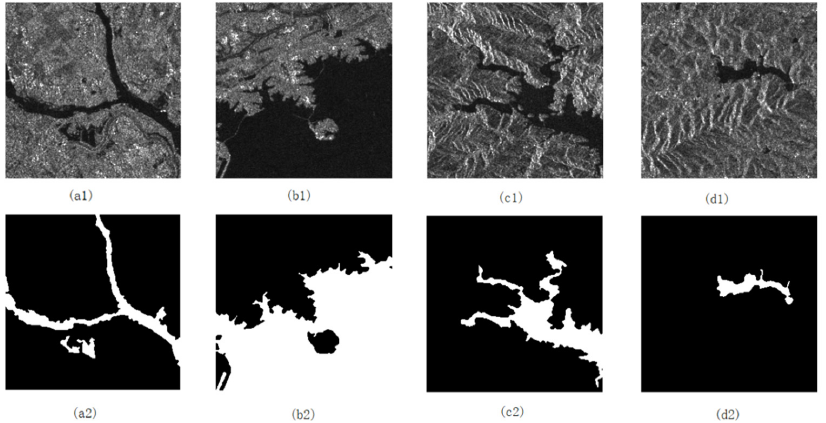
Figure 10. Sample patches: ( a ) small tributary samples with thin strips; ( b ) large, blocky lake sam- ples; ( c , d ) samples of mountain water. ( a1 – d1 ) are SAR images; ( a2 – d2 ) are corresponding label images.